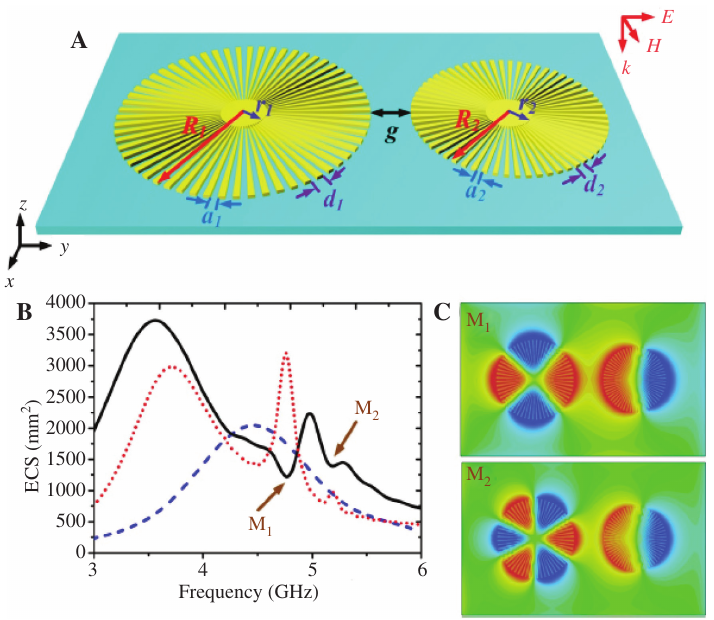
Figure 28: The schematic picture of the ultrathin LSP dimer and the multiple Fano resonance. (A) The configuration of the LSP dimer. (B) The simulated ECS spectra for the LSP dimer and individual LSP disks. The black solid line corresponds to the LSP dimer, where the dips are and M . The red dotted line denotes the big disk, which is illuminated by gazing incidence. The blue dashed line corresponds marked as M 1 2 to the small disk, which is illuminated by normal incidence. (C) Simulation results of the near-field ( E quencies M and M . Reproduced from [49] with 1 2